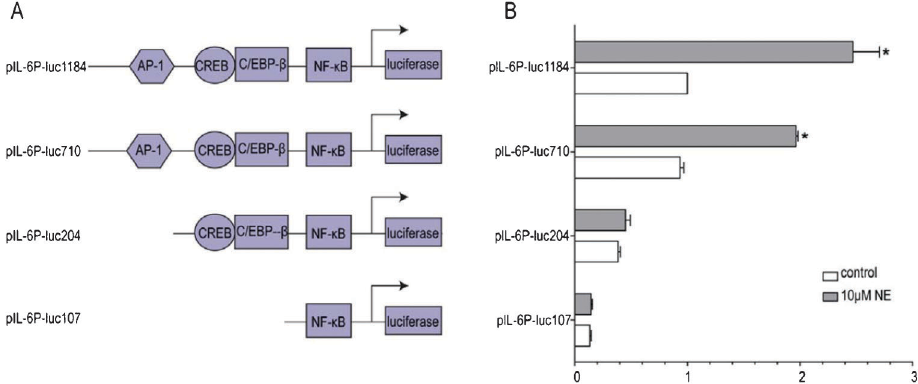
Figure 4. Deletion analysis of IL-6 promoter constructs by 10 m M norepinephrine (NE) in GES-1 cells. A , Structures of the four pIL-6P- luc constructs are shown schematically. The configuration of the promoter region of the human IL-6 gene is illustrated at the top, in which cis -acting elements so far identified are boxed. AP-1 (activating protein-1), CREB (cAMP-responsive element binding protein), C/EBP- b (CCAAT-enhancer binding protein- b ), and NF- k B (nuclear factor k -light-chain-enhancer of activated B cells) binding sites. B , A series of IL-6-luciferase reporter constructs were transfected into GES-1 cells. After overnight incubation, GES-1 cells were treated with 10 m M NE for another 3 h. The cells were lysed and assayed for luciferase activity. Firefly luciferase activity was normalized to co- transfected control Renilla luciferase driven by a TK promoter and expressed as a fold change relative to untreated wild-type IL-6 promoter (pIL-6P-luc1184). Data are reported as means±SE of 3 independent experiments with triplicate measurements. *P , 0.05, compared to untreated wild-type IL-6 promoter (pIL-6P-luc1184) by